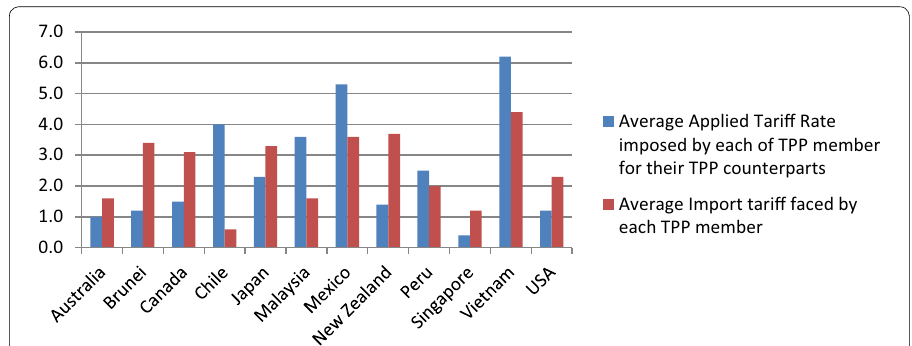
Fig. 1 Average intra-TPP tariffs. Source : Based on Table 1 of Freund et al. (2016), PIIE Briefing 16-1